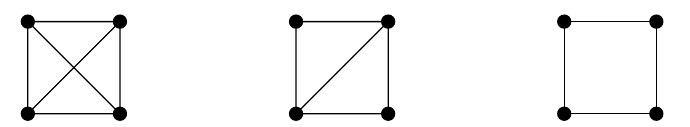
Figure 3 . The four-point structures appearing in a general intersection graph G . Their numbers are denoted by f 6 , f 5 and f 4 from the left to the right, respectively.